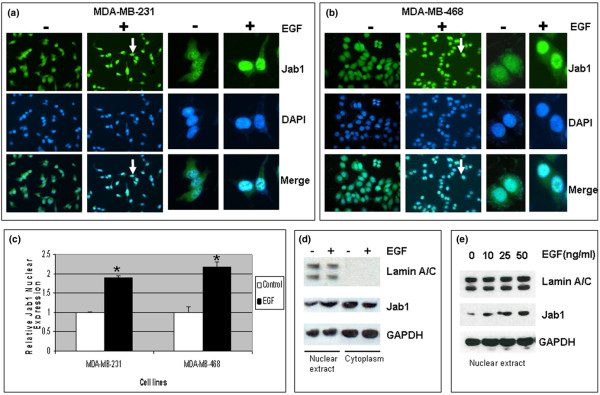
Epidermal growth factor (EGF) stimulates increased nuclear localization of Jab1 in MDA-MB-231 and MDA-MB-468 breast cancer cell lines. (a, b) Immunofluorescence assays. (c) Quantitative image analysis of nuclear Jab1 (bars represent mean ± standard deviation). Statistical analysis was by t test (*P < 0.01). (d) Increased expression of Jab1 in the nucleus relative to cytoplasm, detected by Western blot in MDA-MB-231 nuclear extracts. Lamin A/C was included as a positive control for the nuclear extract, and GAPDH was included as a loading control. (e) Increased Jab1 nuclear expression positively correlated to EGF dose. DAPI, 4'-6-diamidino-2-phenylindole; GAPDH, glyceraldehyde 3-phosphate dehydrogenase; Jab1, c-Jun activation domain-binding protein-1.